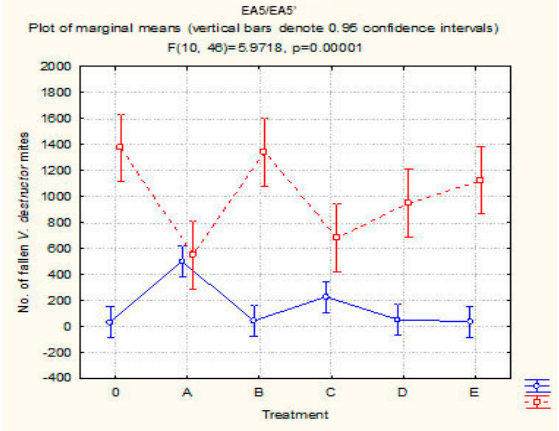
Figure 5. Differences in the number of fallen V. destructor mites between experimental groups (A, B, C, D, E) and control groups (O), during summer (blue lines) and follow-up autumn treatment (red lines), at EA5/EA5 ′ ; mean ± SD. Table 3. Treatment efficacy of varroacides on different experimental apiaries.